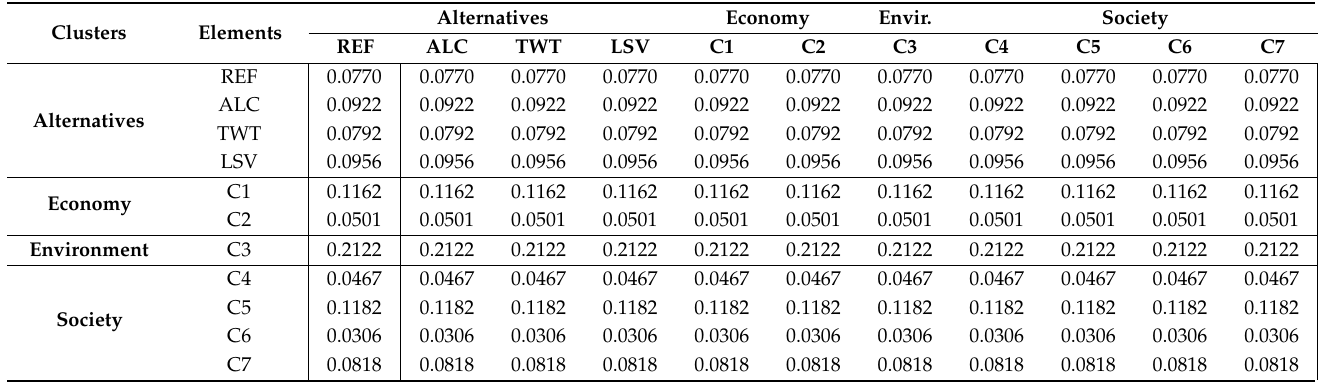
Table 9. Limiting supermatrix from DM 1, displaying the weights of each criterion and the ranking of the